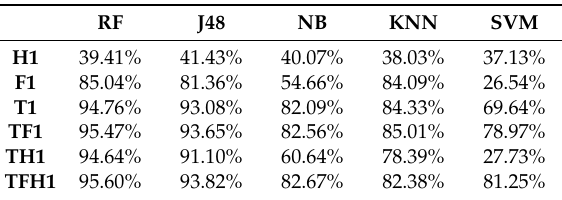
Table 6. The performance of VDM in terms of accuracy on different classifiers and different feature sets with the window size of 5 s at 50% overlapping.